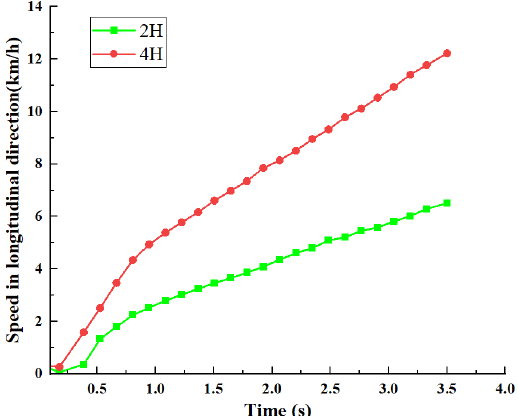
Figure 11. Result of longitudinal vehicle speed simulation.